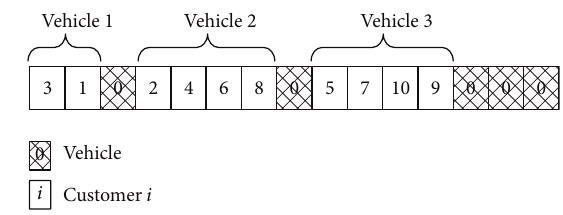
Figure 2: Representation of the individual integer